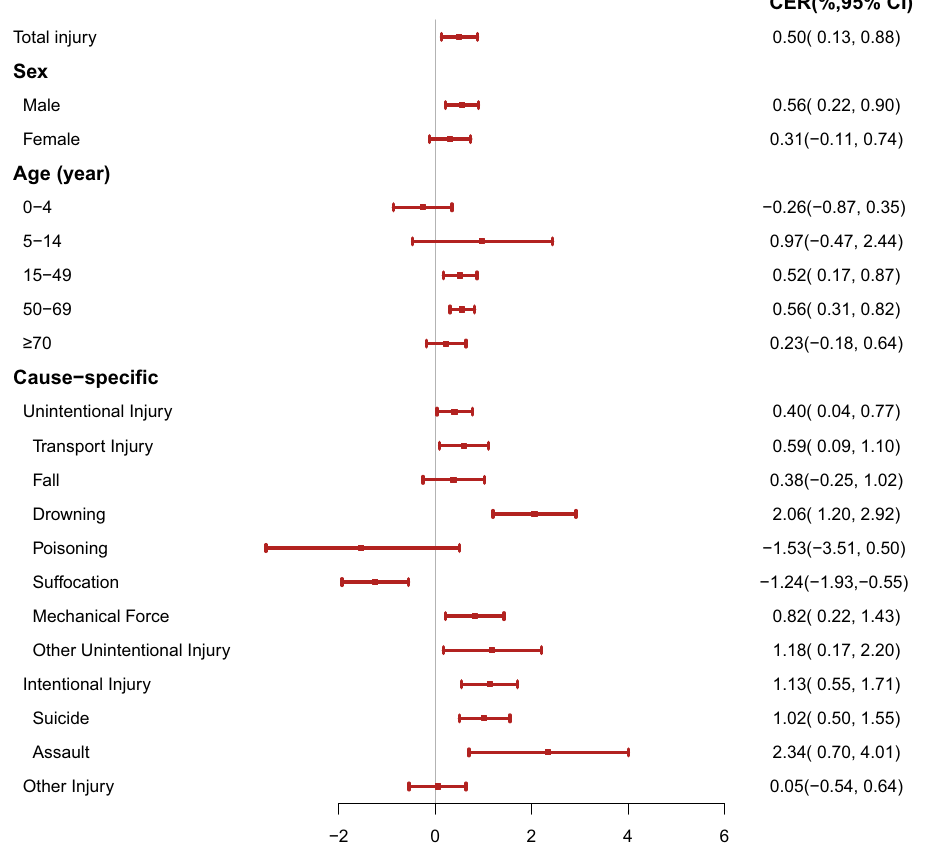
Fig.2|Cumulativeexcessrisk(%)ofinjurydeathsforeach1°Cincreaseindaily mean temperature over 0 – 1 lag days, by age, sex, intention and mechanism. Thesquarereddotsdenotethecumulativeexcessrisk(%).Thehorizontalredlines denote the 95% con fi dence interval. The light gray vertical line denotes the refer- encevalue(CER=0).Aconditionallogisticregressionwithcross-basisfunctionwas used to estimate the province-speci fi c temperature-injury deaths association